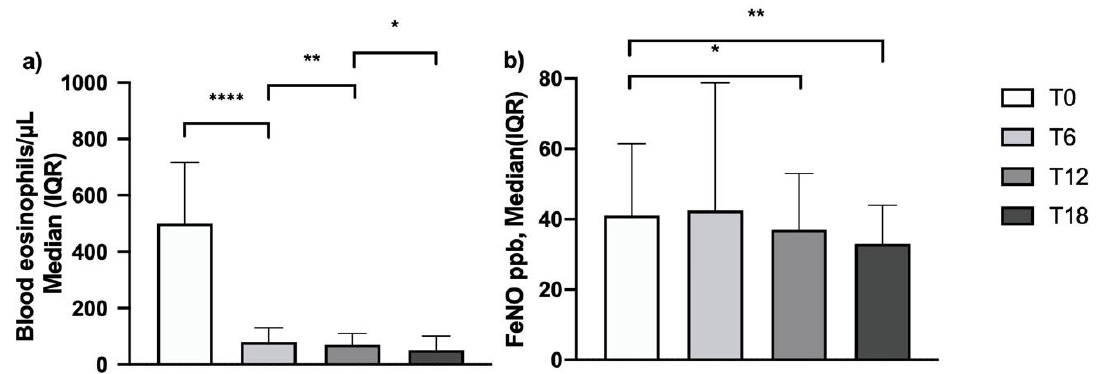
Figure 3. Effects of mepolizumab on blood eosinophilia ( a ) and FeNO ( b ) (*: p = 0.04; **: p = 0.004; ****: p < 0.0001) and FeNO (*: p = 0.01; **: p < 0.001; ns, non-significant).